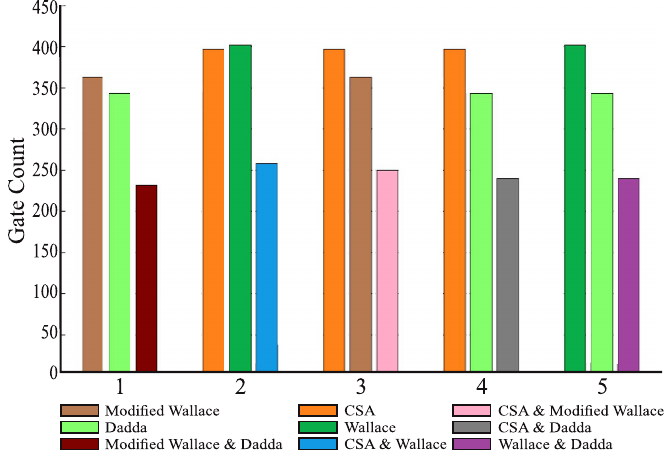
FIG. 7. COMPARISON OF GATE COUNTS OF 8 X 8 PROPOSED MULTIPLIERS WITH THEIR PARENT MULTIPLIERS